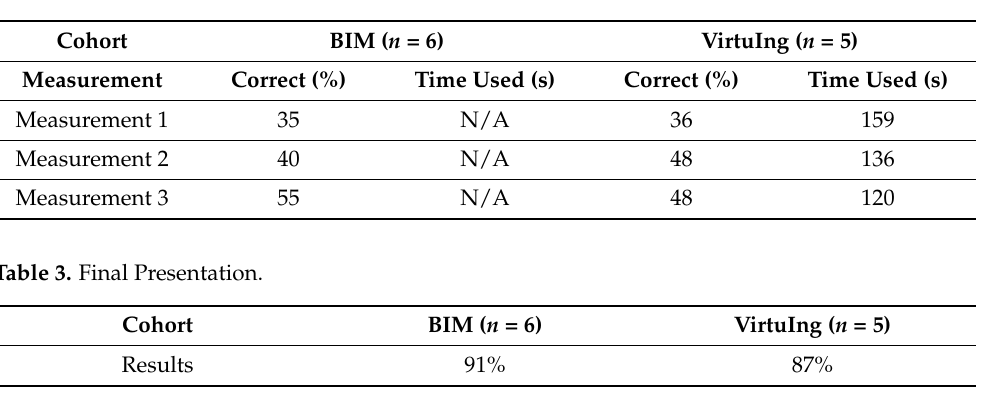
Table 2. BIM Test.